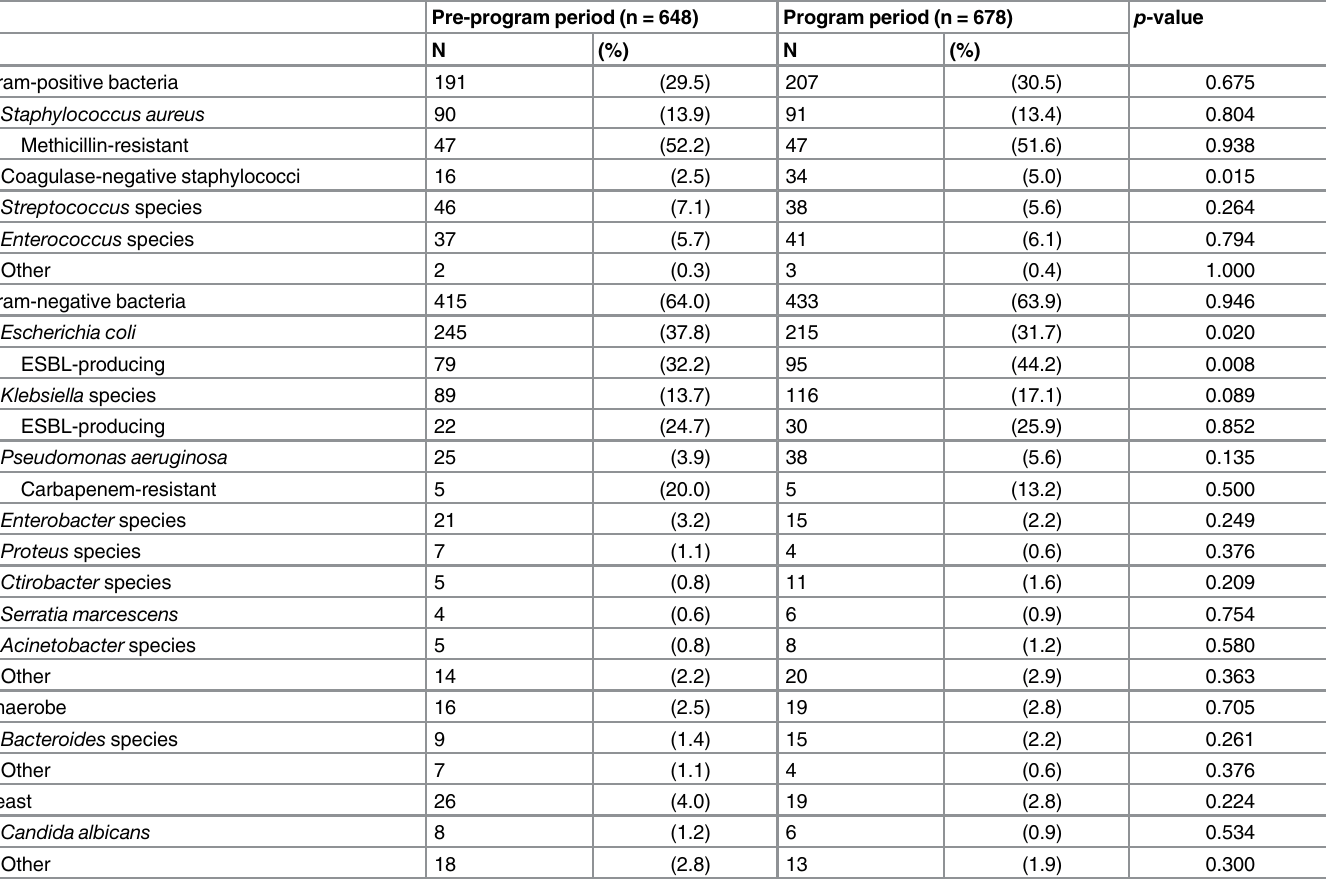
Table 2. Pathogen distribution in bloodstream infection